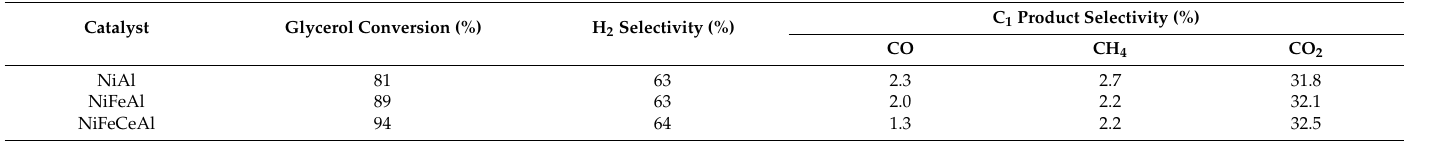
Table 3. Catalytic performance results for SR of glycerol over the Fe and Ce promoted Ni / Al 2 O 3 catalyst [75].